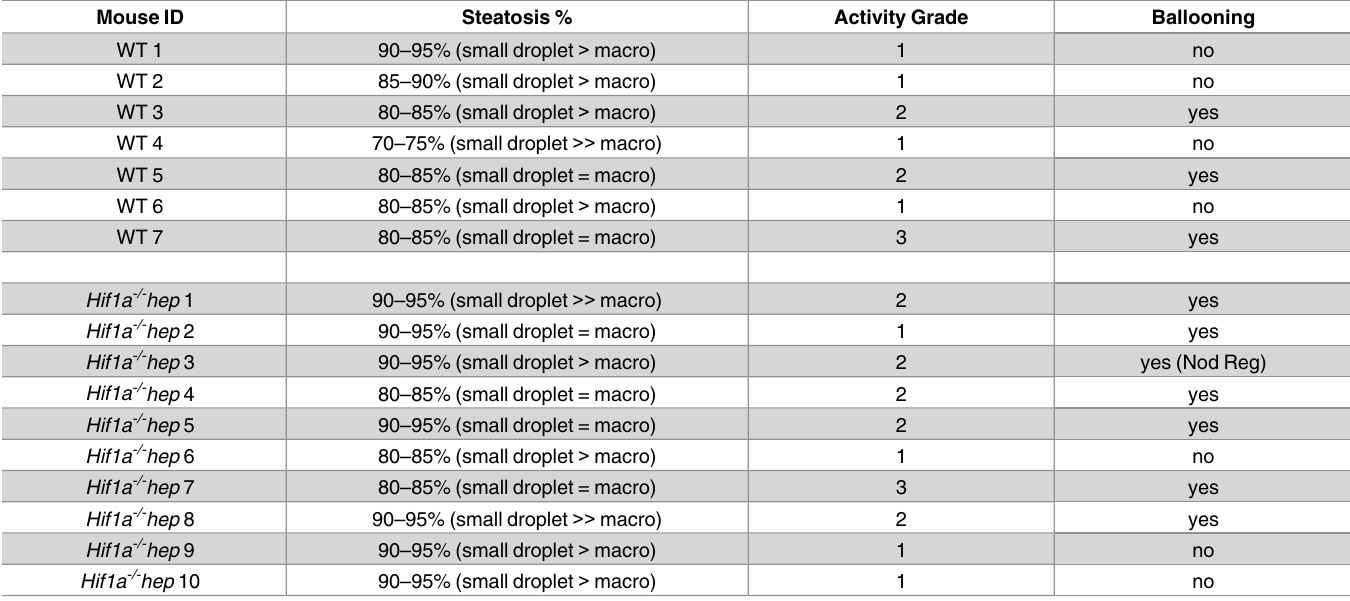
Table 1. Mouse Histologic